Question: Express in one sentence what the figure is showing.
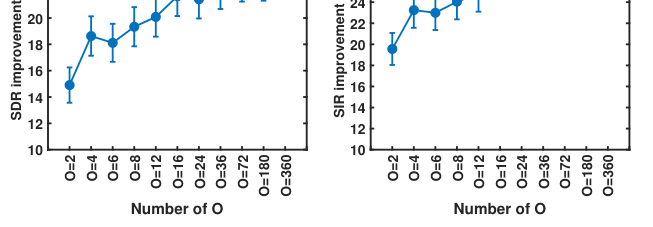
Answer: Average SDR and SIR improvements versus the value of O. Conditions: source signals are from two female speakers in WSJ0 and there is no reverberation.